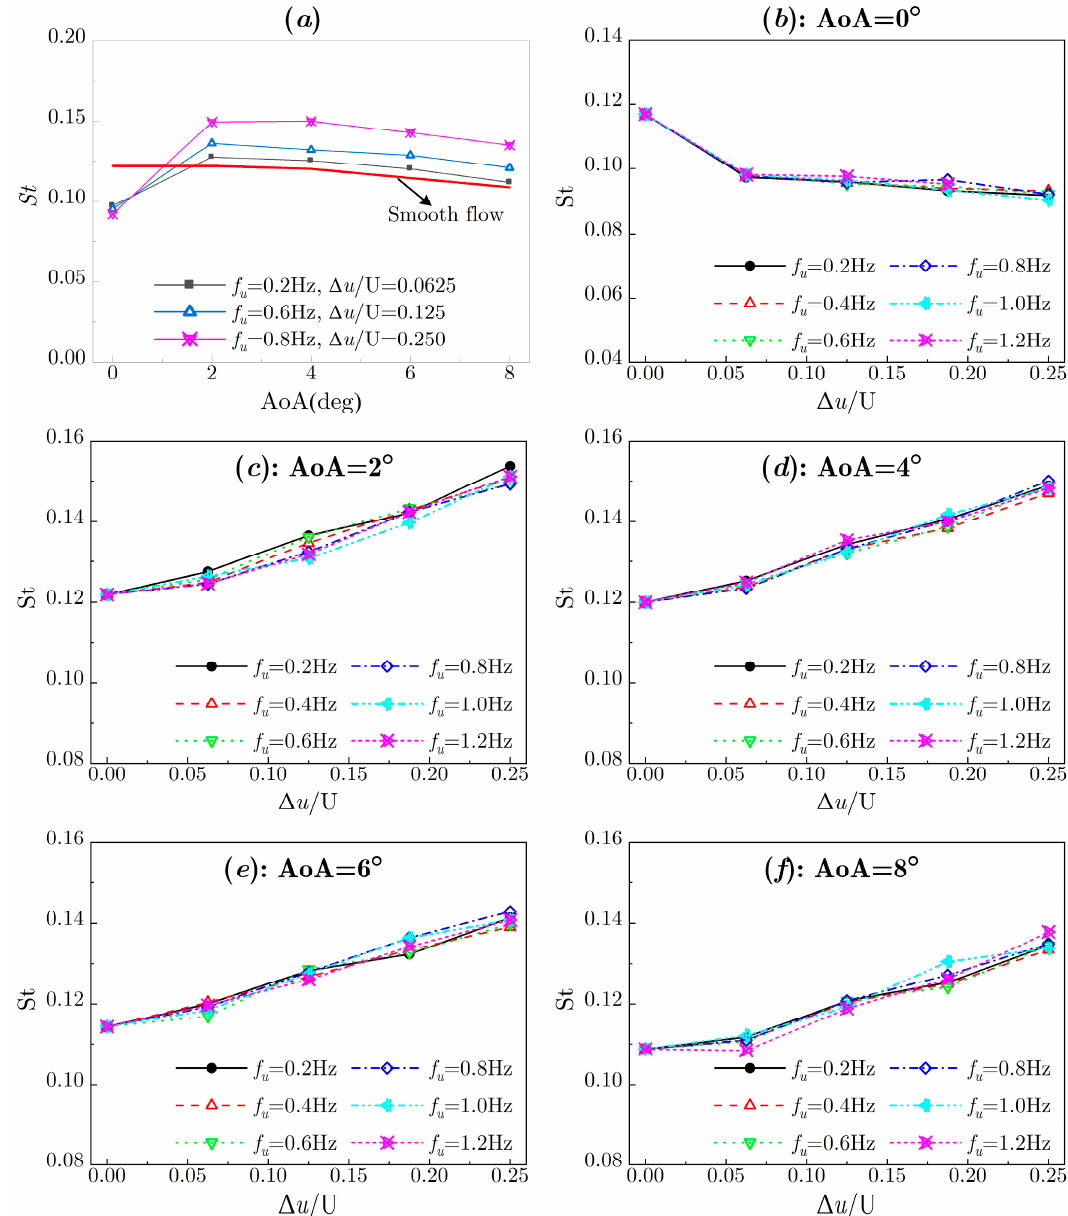
Figure 7. Strouhal number: ( a ) the effects of AoA; ( b – f ) the effects of f u and Δ u /U at AoA = 0°, 2°, 4°, 6°, and 8°, respectively.